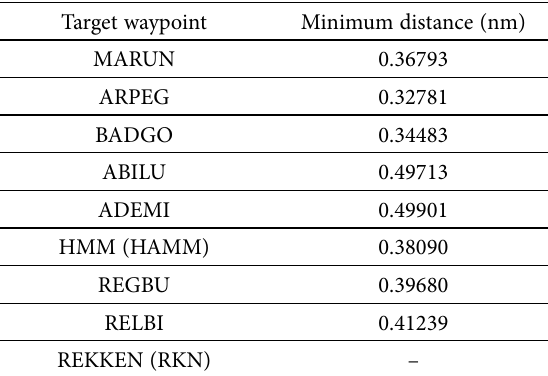
Table 2. Results of minimum distance to the target waypoint